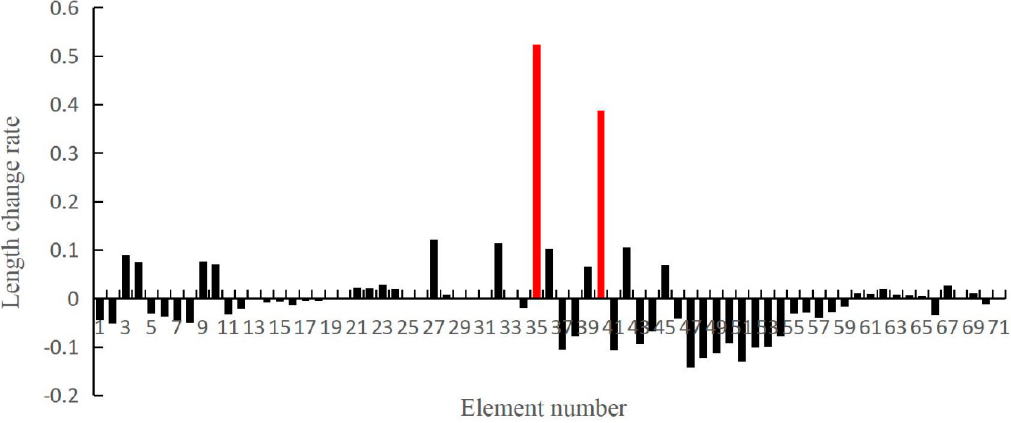
Figure 7. Length change rate of element obtained from the static data (elements 35 and 40 were damaged with an added 5% noise).